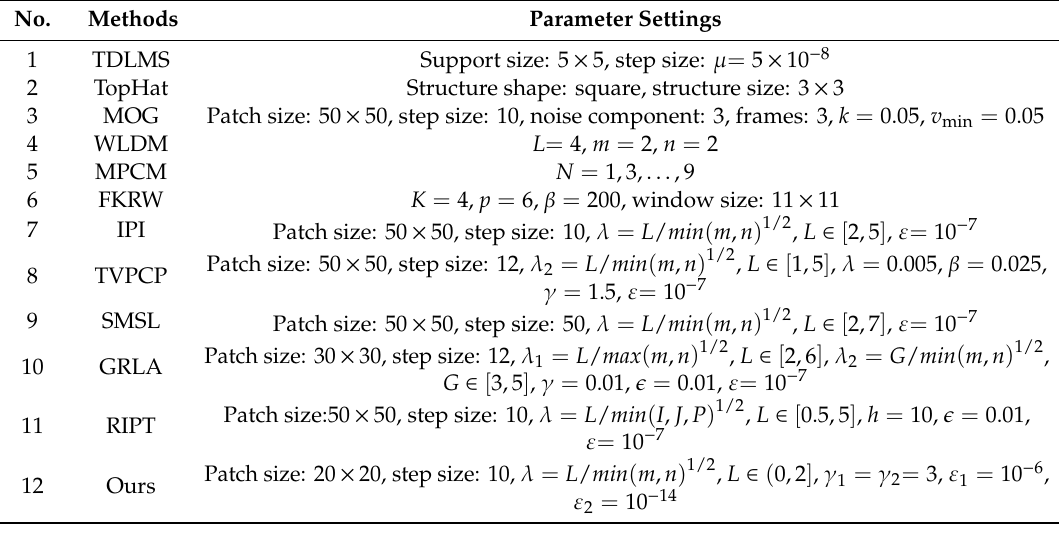
Table 3. All tested methods and their parameter